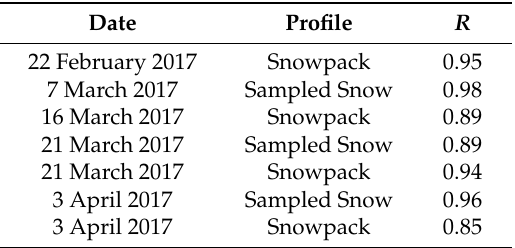
Figure 6. Example of reflectances measured on 7 March 2017 at heights of 73 cm (blue), 64 cm (cyan), 52 cm (magenta), and 34 cm (red). Vertical lines indicate wavelengths 1160 nm and 1260 nm. Table 3. Correlation coefficient ( R ) between SSA and Q for the QST measurements from the snowpack profile and profile of the sampled snow.